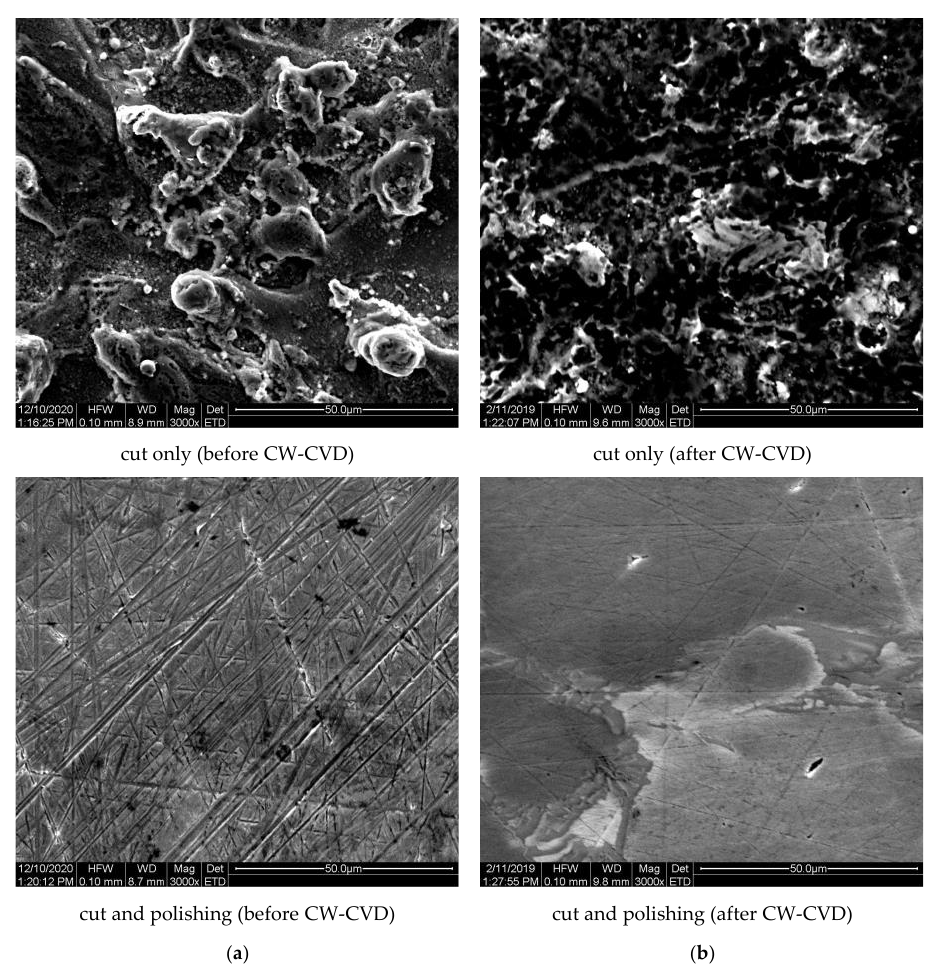
Figure 1. SEM micrographs cut (top) and polished (bottom) sample before ( a ) and after ( b ) CW-CVD. On comparison of the SEM micrographs before and after the CW-CVD process,